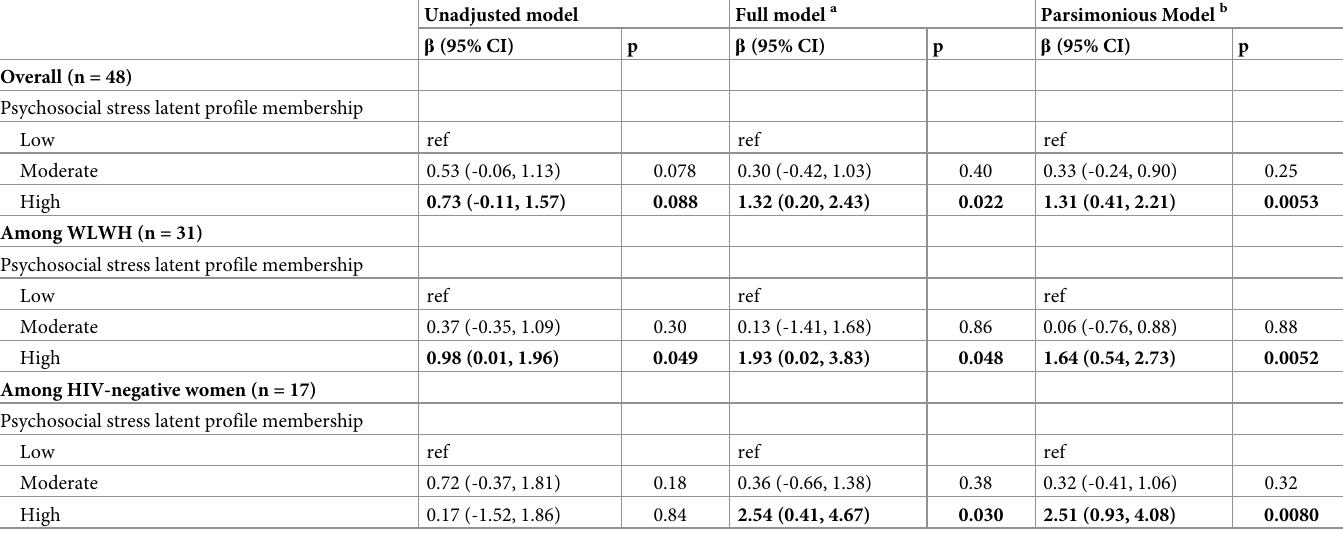
Table 6. Association between psychosocial stress and composite neuroendocrine biomarker index among monoracial non-Hispanic Black women overall and by HIV serostatus (n =